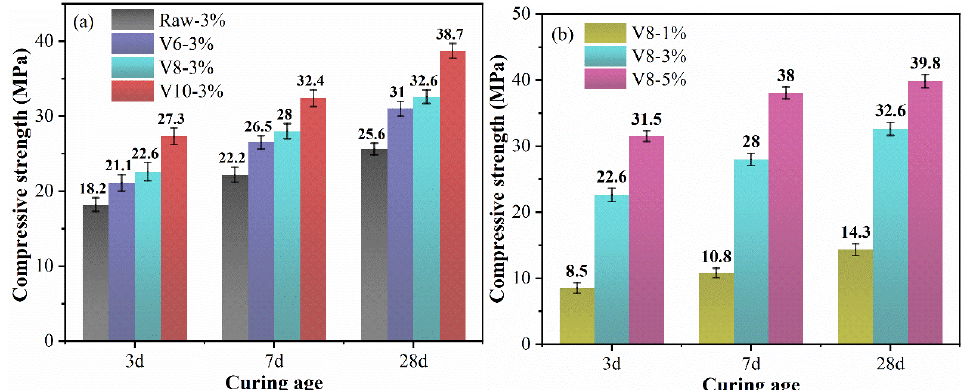
Figure 7. Compressive strength of hardened specimens: effect of BFS fineness ( a ) and effect of NC dosage ( b ).